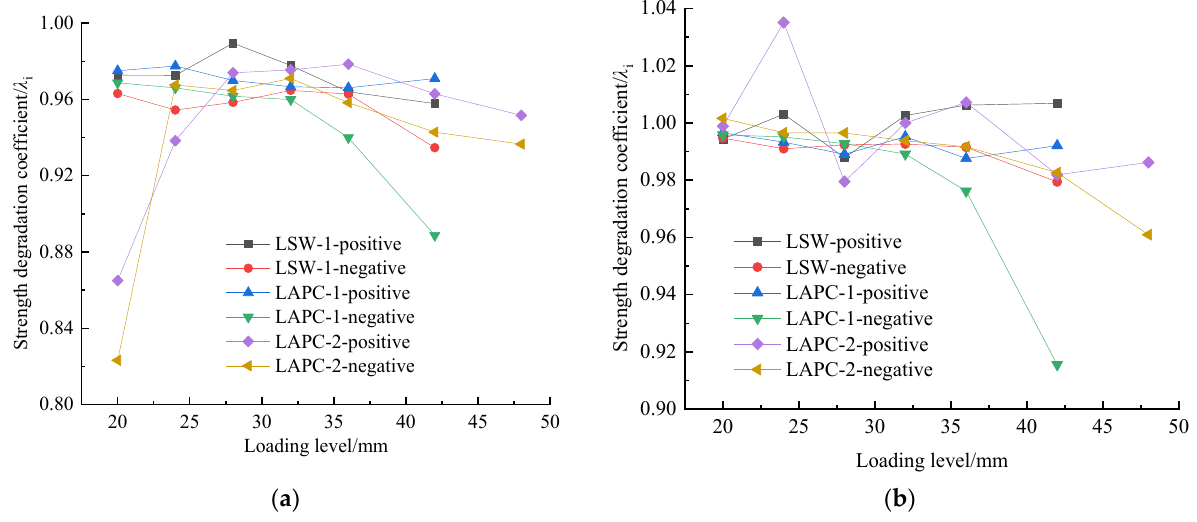
Figure 9. Comparison of strength degradation coefficient of each specimen: ( a ) second load cycle; and ( b ) third load cycle.